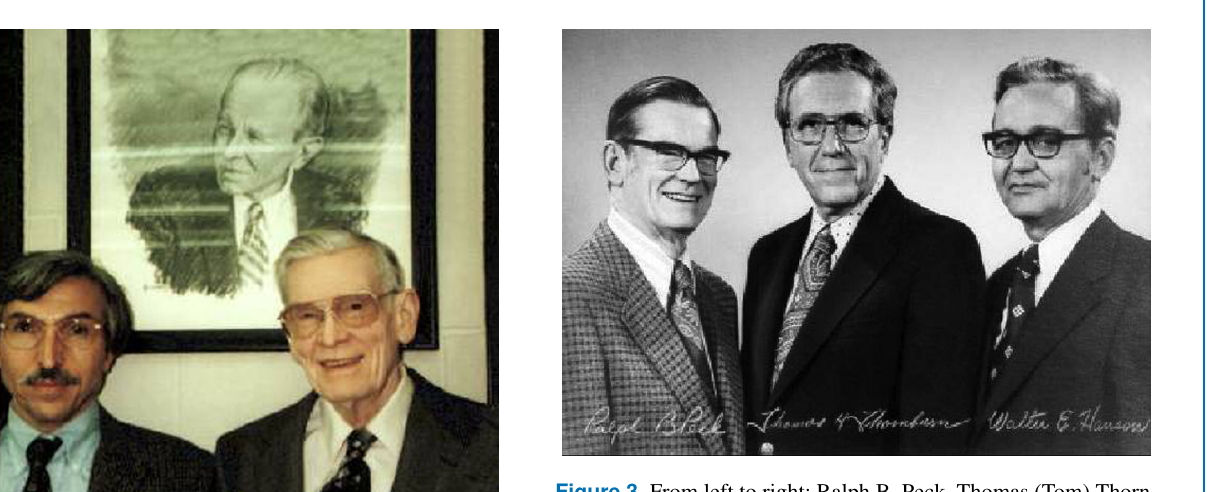
Figure 3. From left to right: Ralph B. Peck, Thomas (Tom) Thorn- burn and Walter (Walt) Hanson. Source: Ralph B. Peck Family. All rights